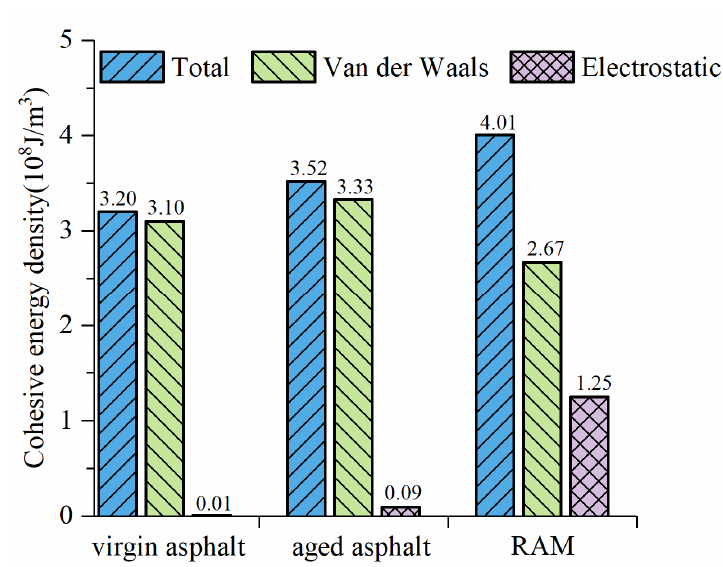
Figure 6. CED values for three types of asphalt models.